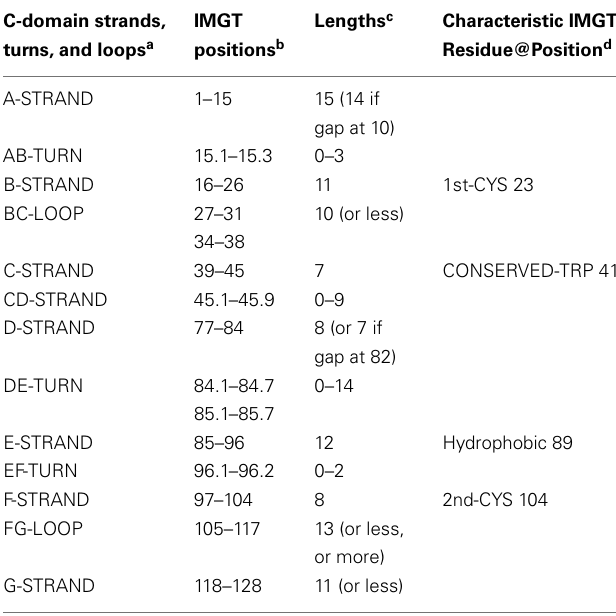
Table 6 | C-domain strands, turns, and loops, IMGT positions, and lengths, based on the IMGT unique numbering for C-domain (C-DOMAIN and C-LIKE-DOMAIN)